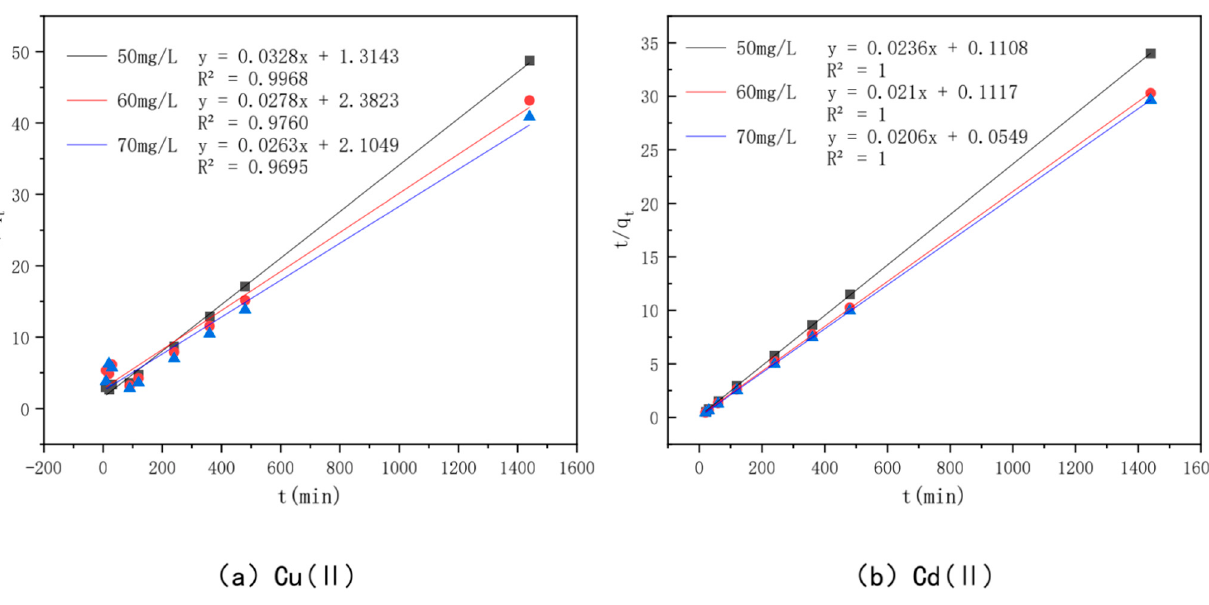
Figure 12. Pseudo-second-order kinetic models of different concentrations of Cu(II)/Cd(II).